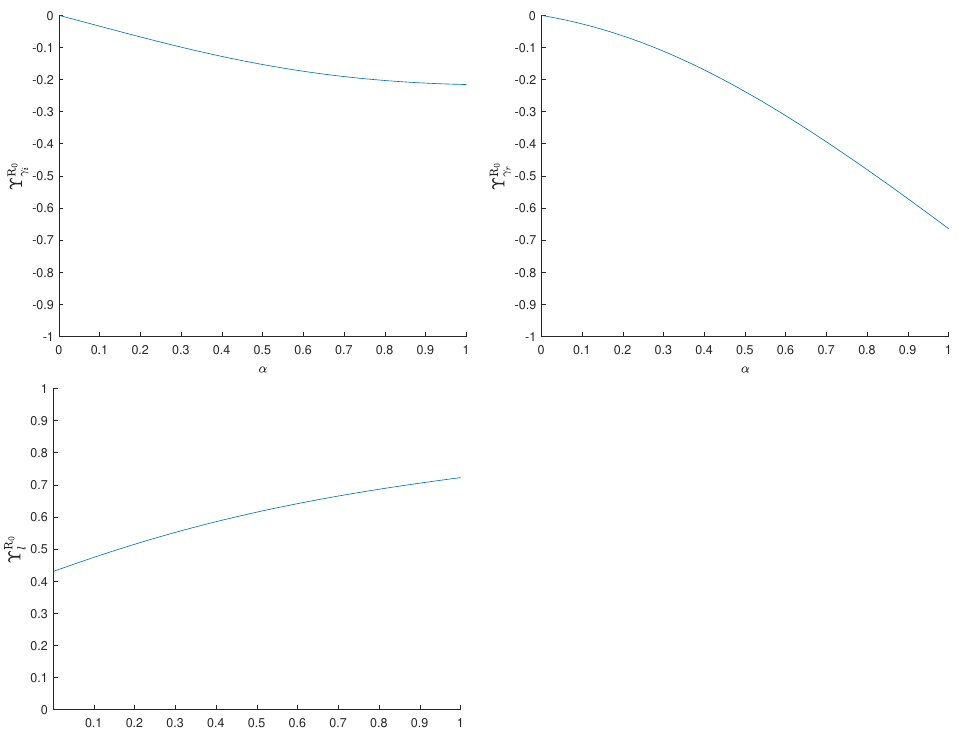
Figure 5. Impact of the variation of α in the sensitivity indexes of β , ρ 1 , γ i , γ r , and l , in agreement with Definition 1.